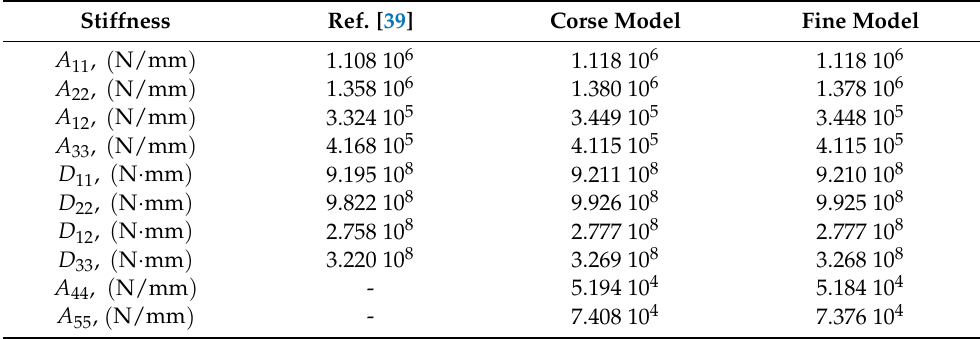
Table 3. The stiffnesses of representative shell element computed for a different approach of modeling confronted with data from [39] for saw tooth geometry.